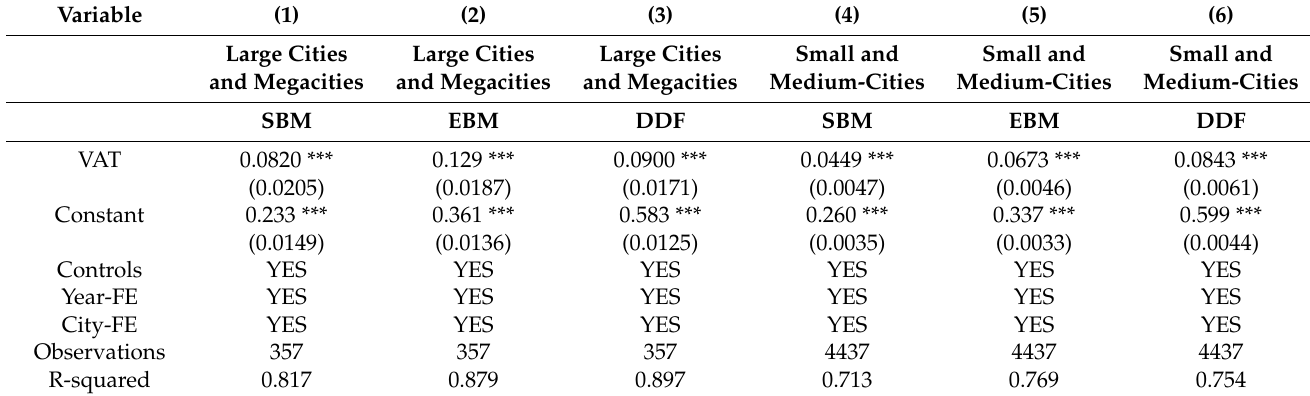
Table 8. Heterogeneity test: City